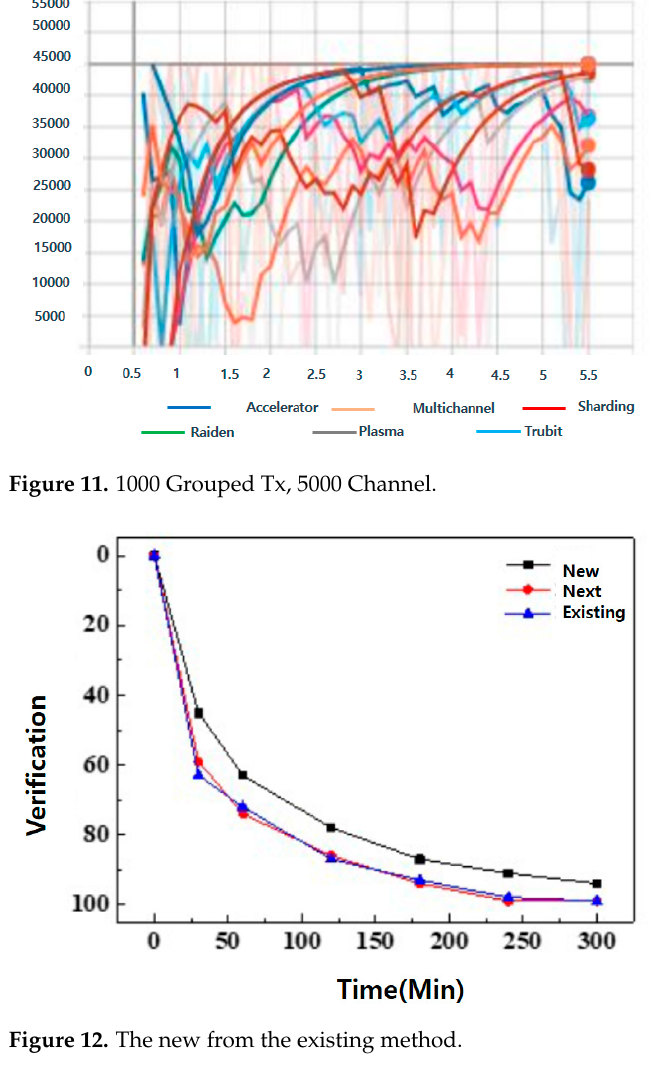
Figure 12. The new from the existing method.